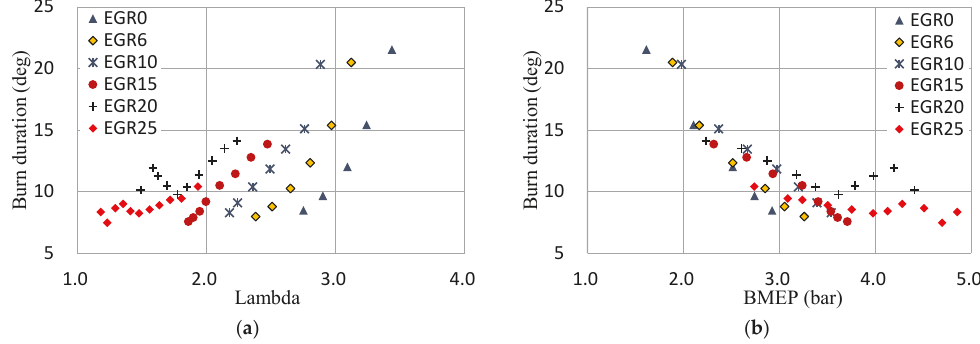
Figure 18. Burn duration with respect to: ( a ) Lambda; ( b ) BMEP.